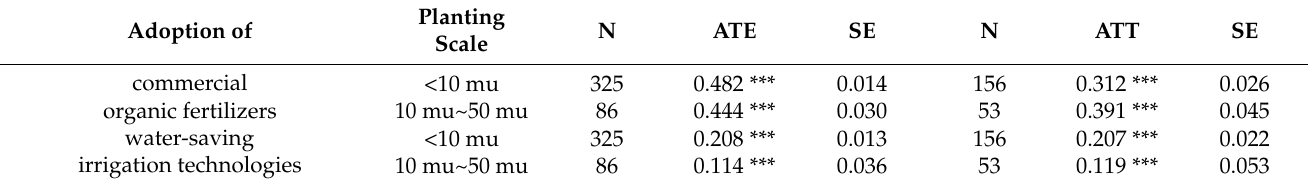
Table 6. Analysis of planting scale differences in the average treatment effect of commercial organic